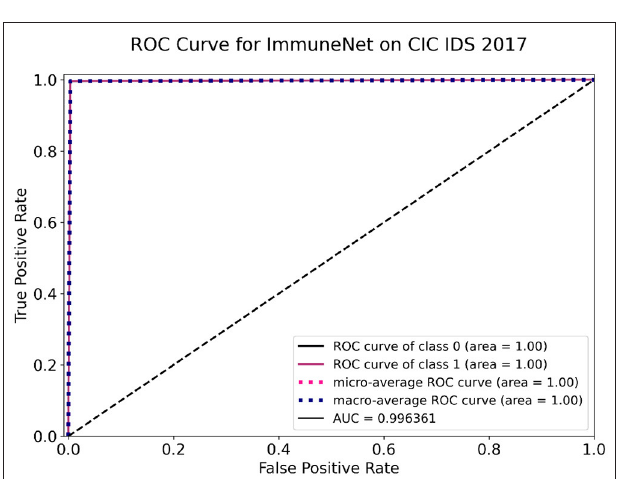
FIGURE 11 | Receiver operating characteristic (ROC) curve of ImmuneNet on CIC IDS 2017 dataset.